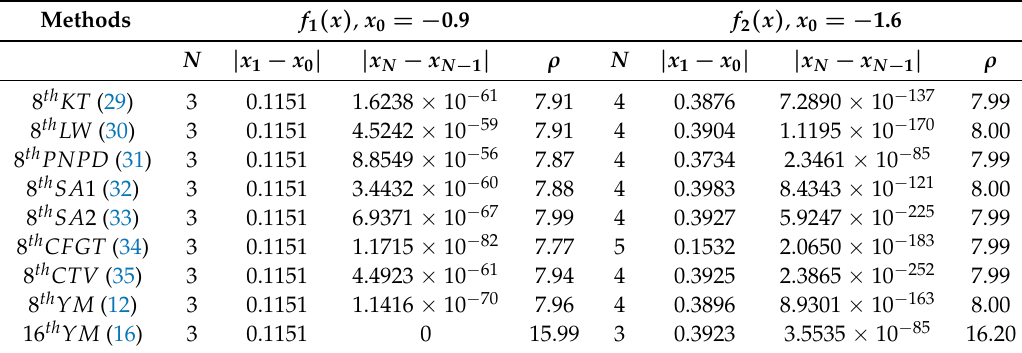
Table 3. Numerical results for nonlinear equations.